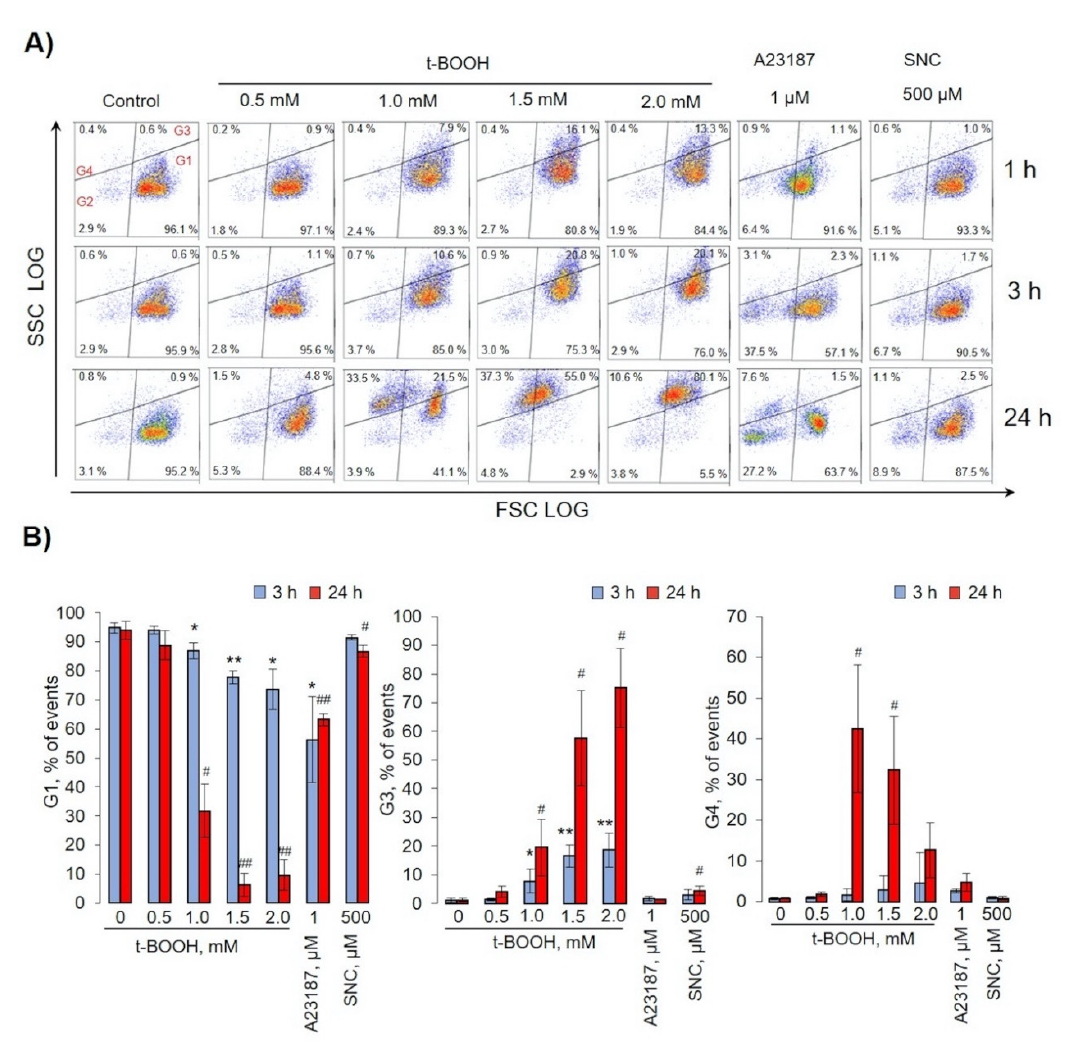
Figure 2. Oxidative stress induced by t-BOOH-triggered RBC transformations and microvesicle formation. RBCs (0.5 × 10 9 cells/mL) were incubated at indicated concentrations of t-BOOH, A23187, and S-nitroso-L-cysteine (SNC) at the indicated times. Gate 1 represents control RBCs, gate 2—microparticles (MPs), gate 3—transformed RBCs, and gate 4—microvesicles (MVs). ( A ) Representative dot plots out of six independent experiments. ( B ) Quantification of presented data expressed as mean ± SD, n = 6. One-way ANOVA, Tamhane T2 (G1, G2 24 h, G4), or Tukey HSD post hoc (G2 3 h) were used where appropriate. * p < 0.05, ** p < 0.001 compared to control (t-BOOH 0mM, 3 h); # p < 0.05, ## p < 0.001 compared to control (t-BOOH 0mM, 24 h).